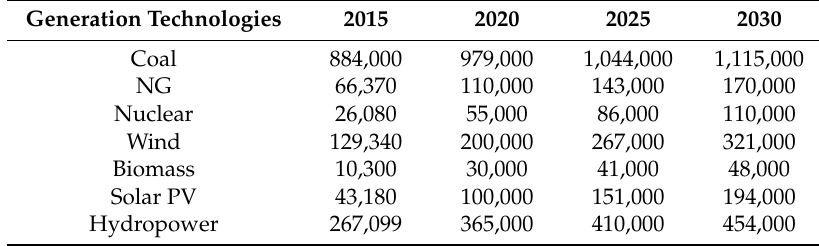
Table 8. Cumulative capacity deployments (in MW) for China in New Policies Scenario [72].